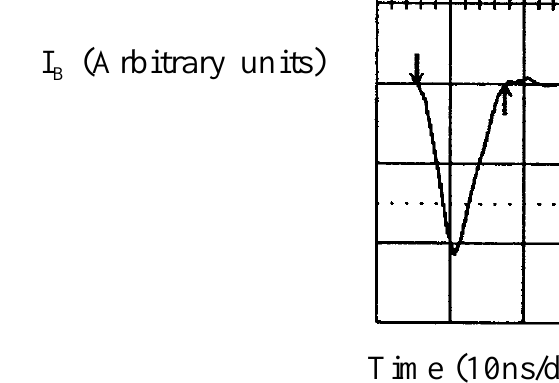
FIG. 10. Debunching of the beam when (cid:86) (cid:114)(cid:102) is set to 0 after the beam is bunched. The vertical scale is arbitrary and the time between traces is 2.5 ms. The traces have been normalized to a constant